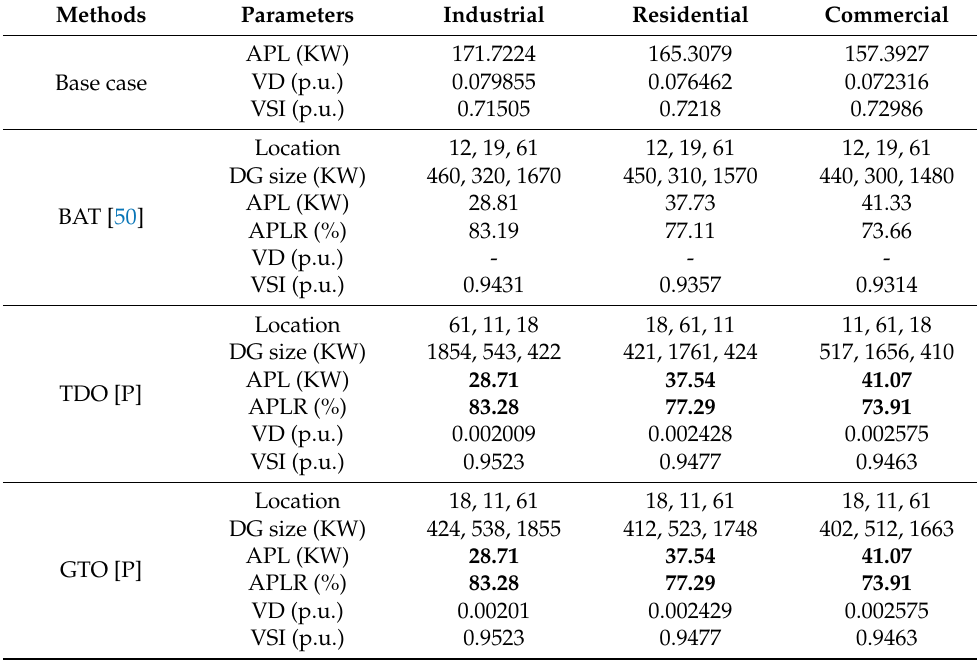
Table 13. Comparative results of OADG for a 69-bus RDN for the SOF (APL minimization) at unity pf (PV Type) in a VP load